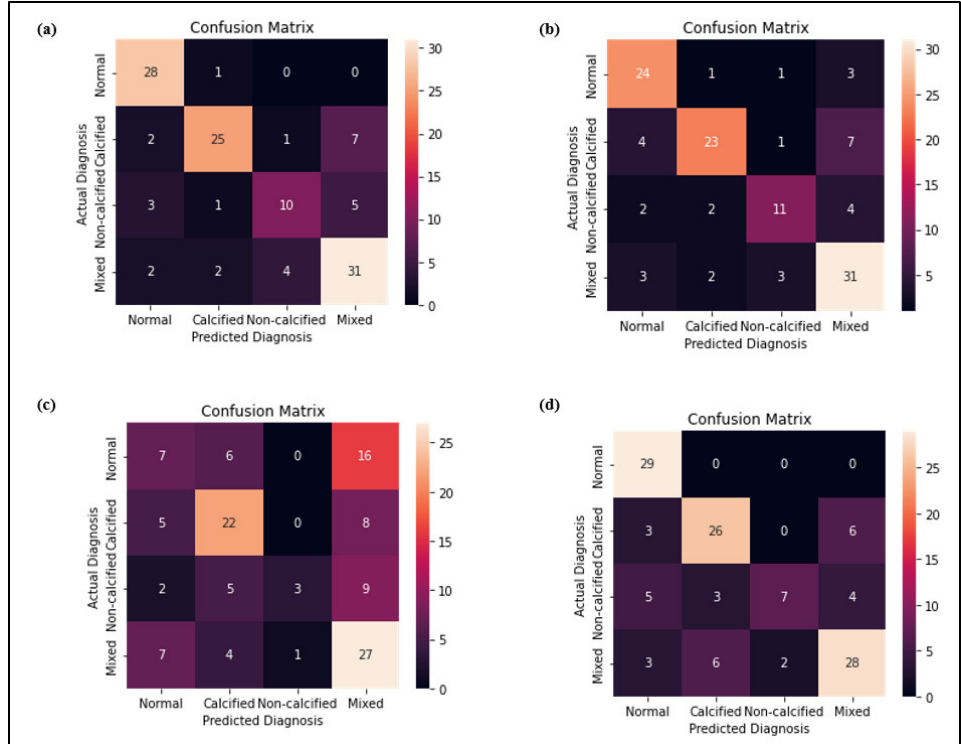
Figure 7. Heatmap confusion matrix for ( a ) Model 1, ( b ) Model 2, ( c ) Model 3 and ( d ) Model 4. Each column of the matrix represents the occurrence in a predicted class, whereas each row represents the occurrence in an actual class.